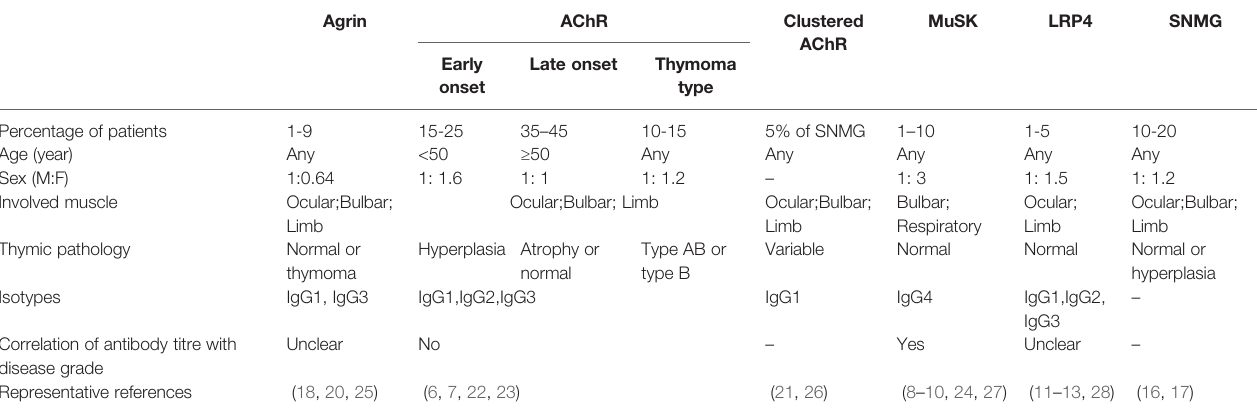
TABLE 4 | Comparison of characteristics of MG serology